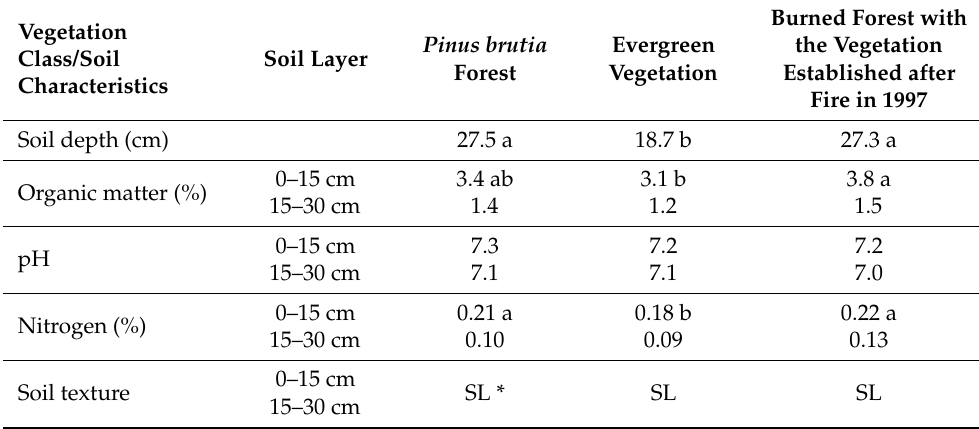
Table 5. Soil characteristics in the three main vegetation classes of the studied WUI area. Values in the same row followed by different letters indicate significant differences between